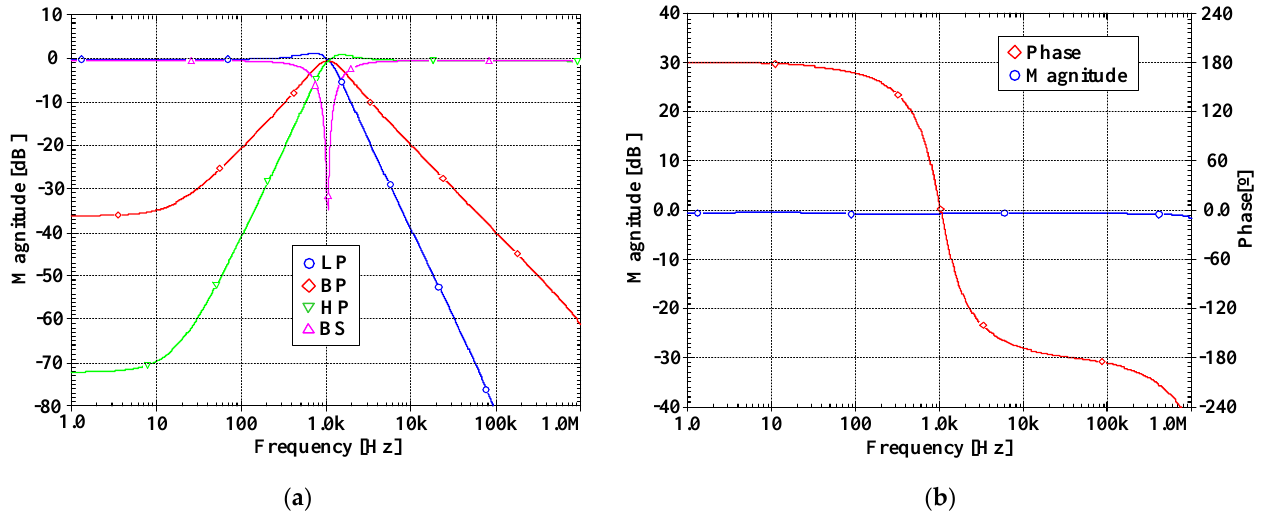
Figure 7. The simulated frequency responses of the VM filter: ( a ) LP, BP, HP, BS filters; ( b ) AP filter.